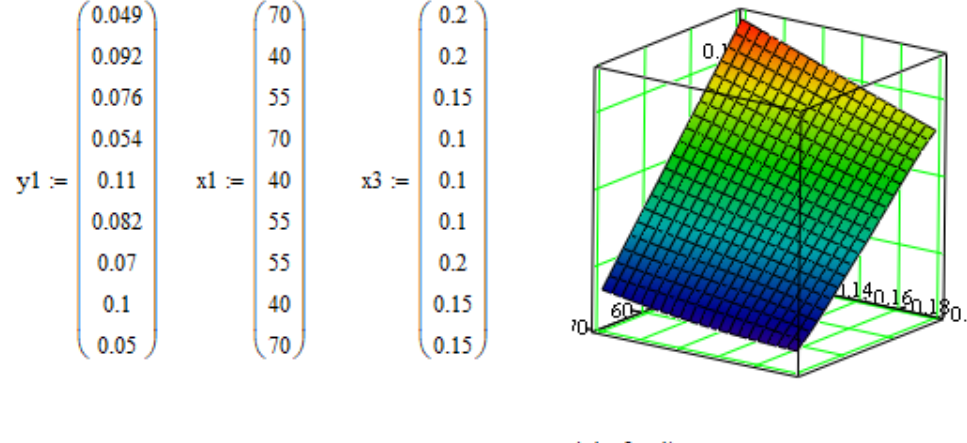
Fig. 1. Graphic interpretation of the experimental